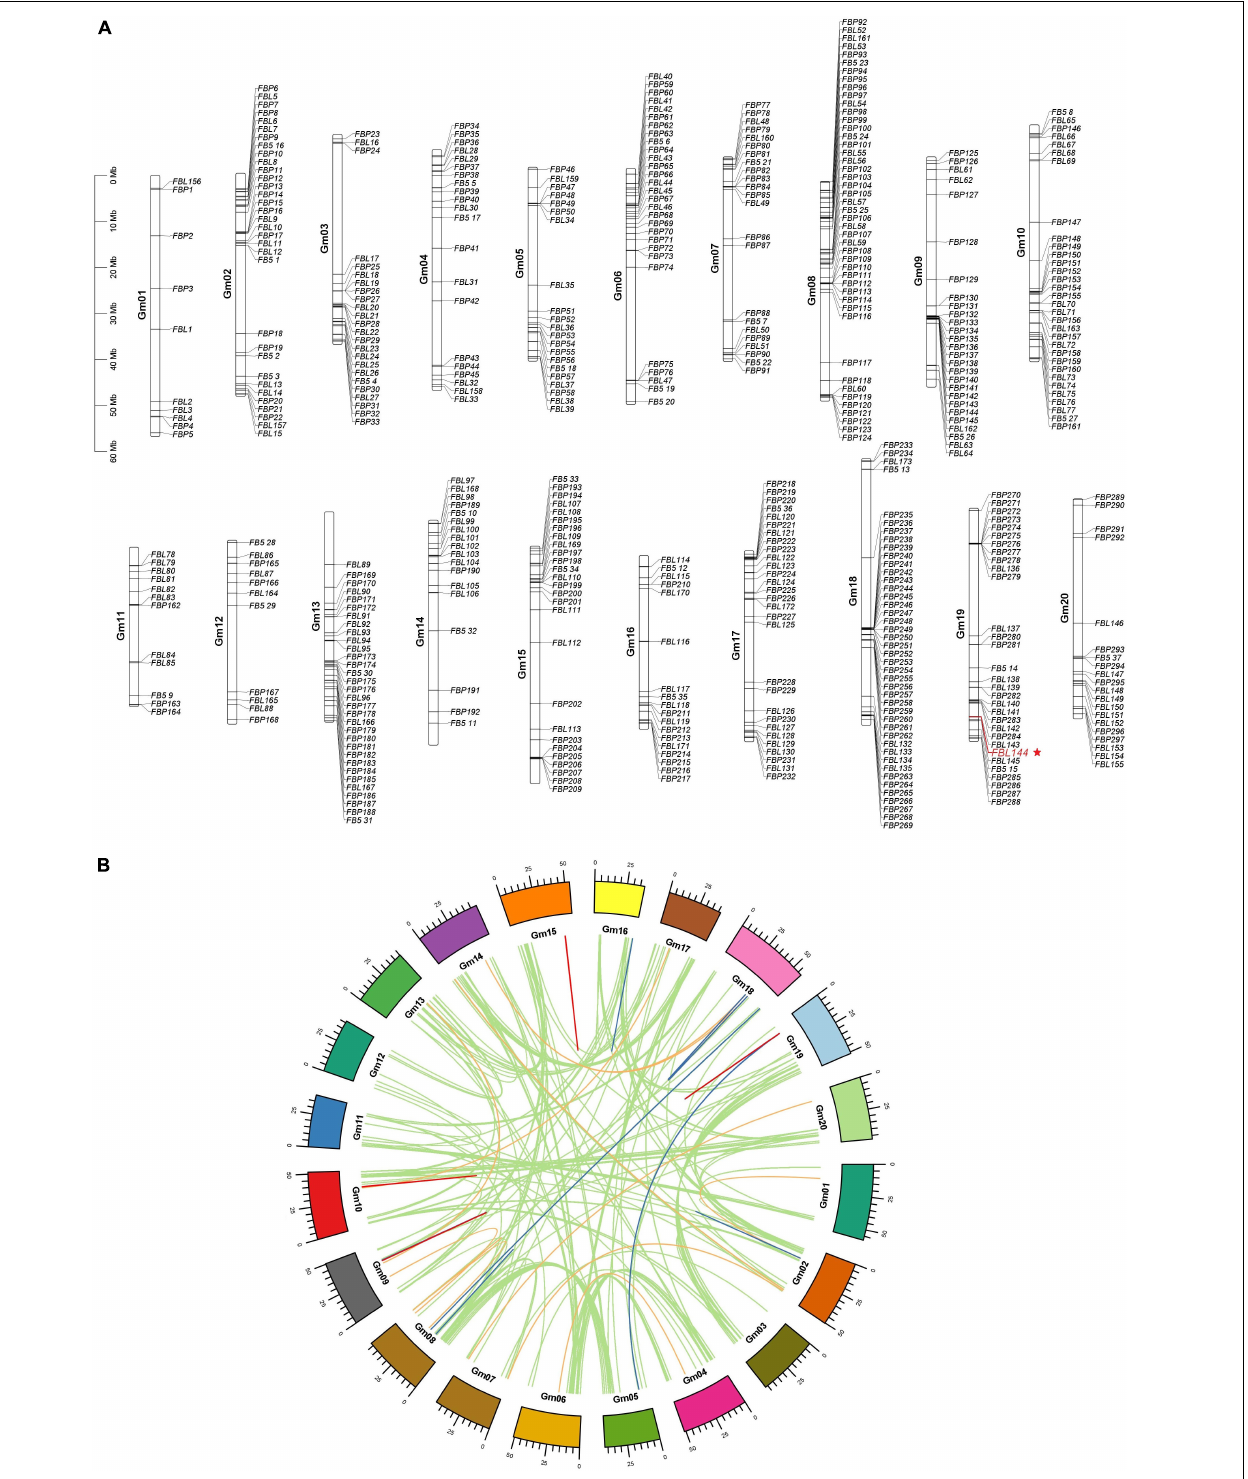
Frontiers in Plant Science |